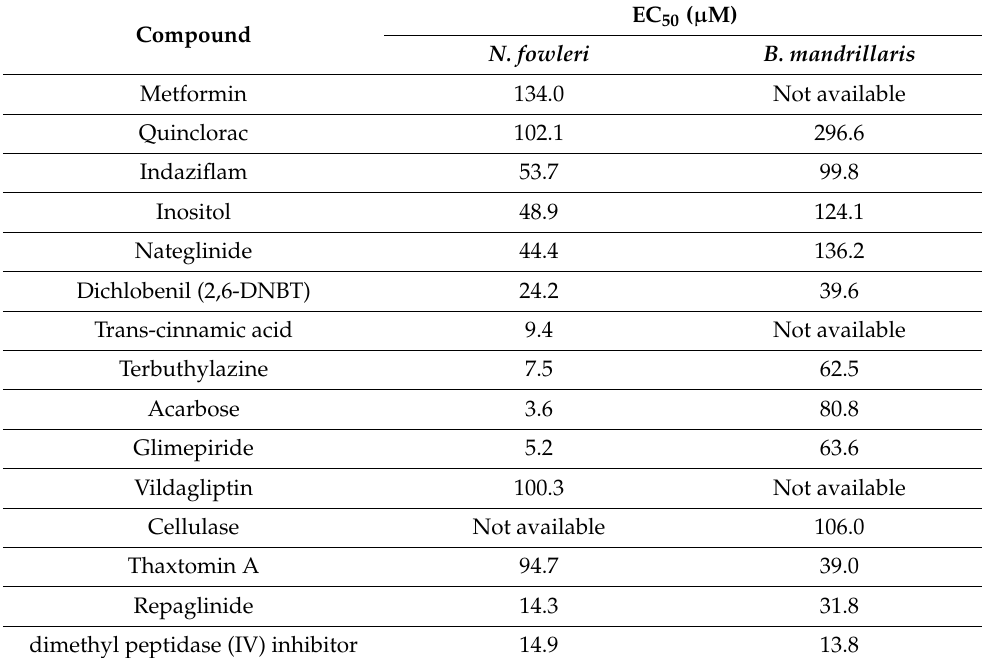
Table 2. Half maximal effective concentration (EC 50 ) of the compounds against N. fowleri and B. mandrillaris